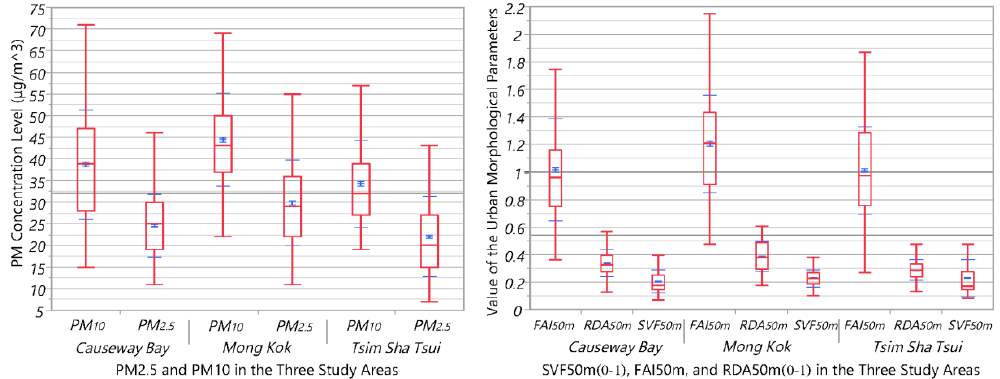
Figure 3. The quantiles box plots (10%, 25%, 50%, 75% and 90%; Mean and Standard Deviation) of PM 2.5 and PM 10 concentration levels and the three covariates (SVF 50m , FAI 50m and RDA 50m ) in the three study areas.